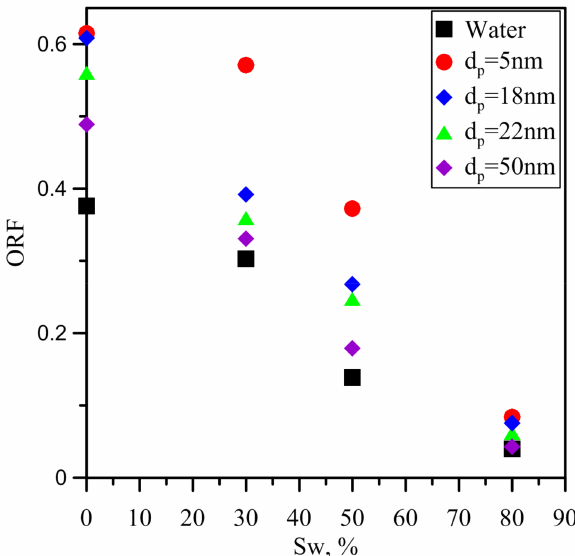
Figure 11. Dependences of ORF on particle sizes in SiO 2 nanosuspension at different water